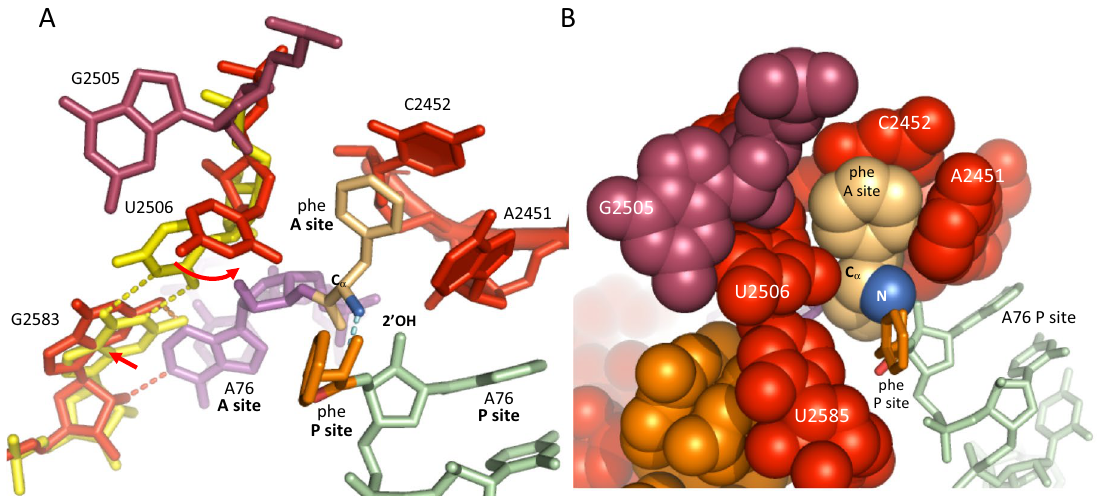
Figure 1. Compaction of the PTC around the incoming aminoacyl ester. ( A ) Induced-fit mechanism of the PTC 1 . In the absence of A-site substrate, U2506 preferentially* wobble base pairs with G2583 (yellow dotted lines) (pdb 5kcr) 11 . This interaction brakes when the terminal A76 of an incoming tRNA binds to and shifts the position of G2583 (orange dotted lines and red arrow). As a result, U2506 moves to another equilibrium position (curved red arrow) that squeezes the Cα carbon against the 2 ʹ OH of the A76 of the P site tRNA (pdb 4v5d) 12 , settling the amino group into a proper orientation for nucleophilic attack (blue dotted line). Superimposition achieved with Pymol . ( B ) Situation after induction, with atoms shown with van der Waals radius. The PTC wraps around the aminoacyl ester (pdb 4v5d) 12 . *An examination of ribosome structures reveals that U2506 does not always base pair with G2583 in the absence of A-site tRNA (Y. Polikanov, pers. comm.). However, in the presence of both A-site and P-site tRNAs substrates, U2506 is always found in an induced position which contains the Cα carbon of the amino acid. The PTC superimposition shown in A involves E. coli (pdb 5kcr) and T. thermophilus (pdb 4v5d) ribosomes. The PTC being highly conserved, all residues involved in the induced-fit mechanism are identical in both